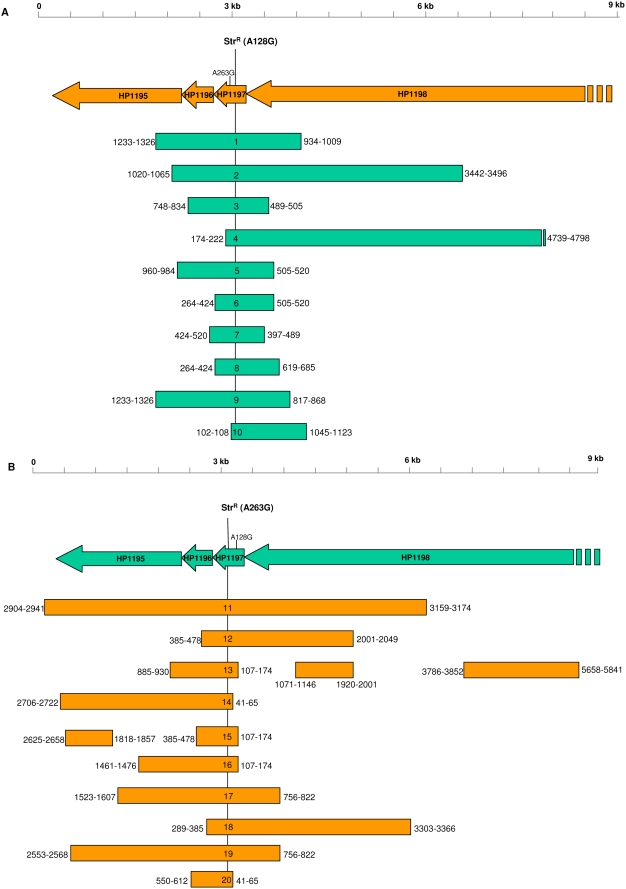
Length of imported DNA flanking the point mutation conferring StrR following transformation with chromosomal DNA from a donor StrR
H. pylori strain.The values on either side of the bars indicate the distance (bp) from the StrR mutation to two single nucleotide polymorphisms (SNPs), reflecting differential susceptibility to restriction endonucleases that define the recombination endpoints. The endpoint of each DNA segment was designated as the position halfway between the two SNPs. The recombination endpoints were determined by sequencing ∼1 kb near ends indicated by restriction analysis of PCR amplicons. (A) Donor DNA from StrR strain 26695 → Recipient J99 cells. The point mutation in 26695 gene HP1197 conferring streptomycin resistance (A128G) was present in all ten independent transformants; an alternate streptomycin resistance mutation (A263G) present in naturally StrR J99 was not observed. (B) Donor DNA from StrR strain J99 → Recipient 26695 cells. The point mutation in JHP1121 conferring streptomycin resistance (A263G) was present in all ten independent transformants; an alternate streptomycin resistance mutation (A128G) present in naturally StrR 26695 was not observed. For transformants 11,12,14,15,16, and 17, the 8517 bp region (from 2278 bp upstream to 6239 bp downstream) that flanks the StrR mutation was subjected to sequence analysis to completion.